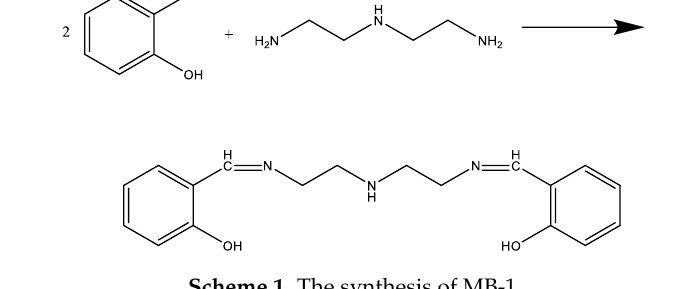
Scheme 1. The synthesis of MB-1. Materials 2019 , 12 , x FOR PEER REVIEW